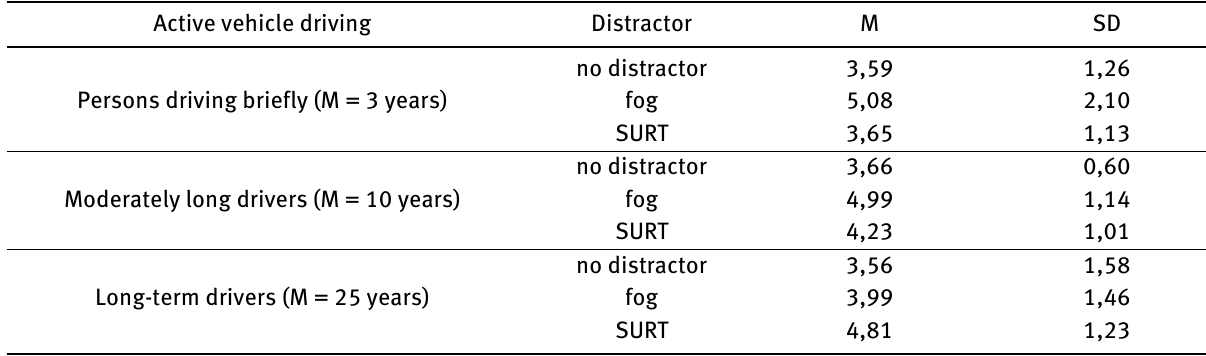
Table 4: Driver response times during driving without distractors, driving in fog and driving with SURT versus years of active driving, N = 95. Active vehicle